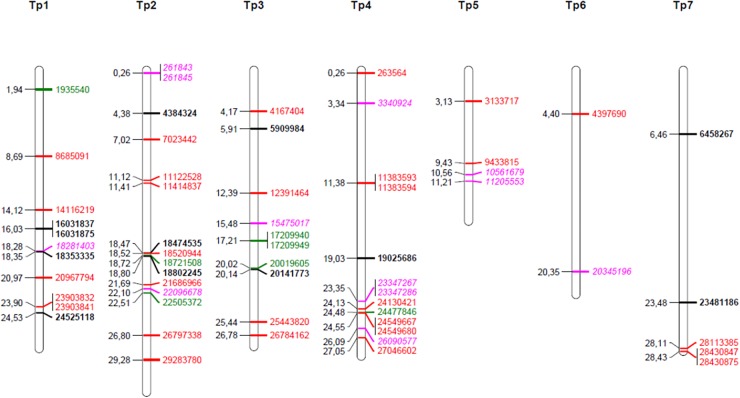
Map positions of chromosomal SNPs found to have been under selection. Black bold; selected in four survivor populations (pure stand, sown at high density) as compared to the original, sown population (study 1), red; differentially selected in survival populations from pure stand as compared to survival populations from species mixtures (study 3), green; differentially selected in populations as compared to populations sown at low seeding density (study 3), pink italic, selection affected by both stand type and seeding density (study 3).